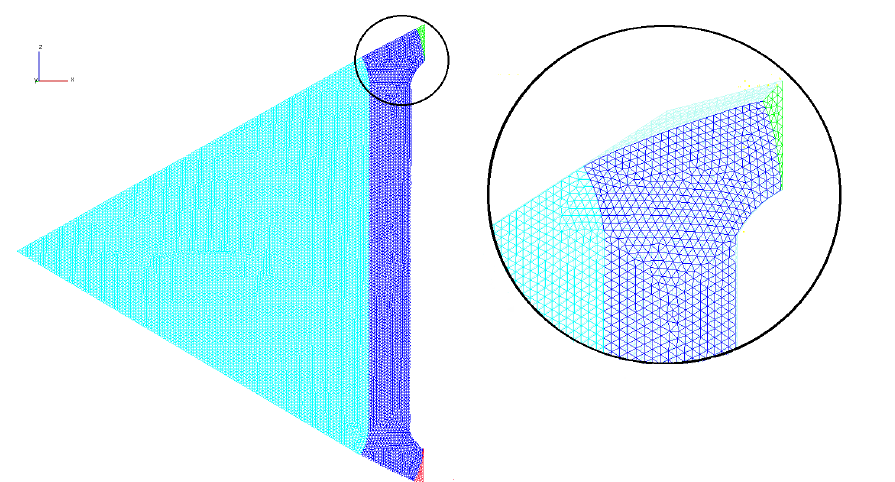
Figure A1. Mesh used for numerical simulation of the interior of the foam with film thickness of 5 µ m. The image shows a 3D view of the computational mesh used for the simulation, consisting of 90k number of elements. To generate the mesh, the GAMBIT software was used to create a tetrahedral mesh, which was then imported into AVL FIRE for simulation.